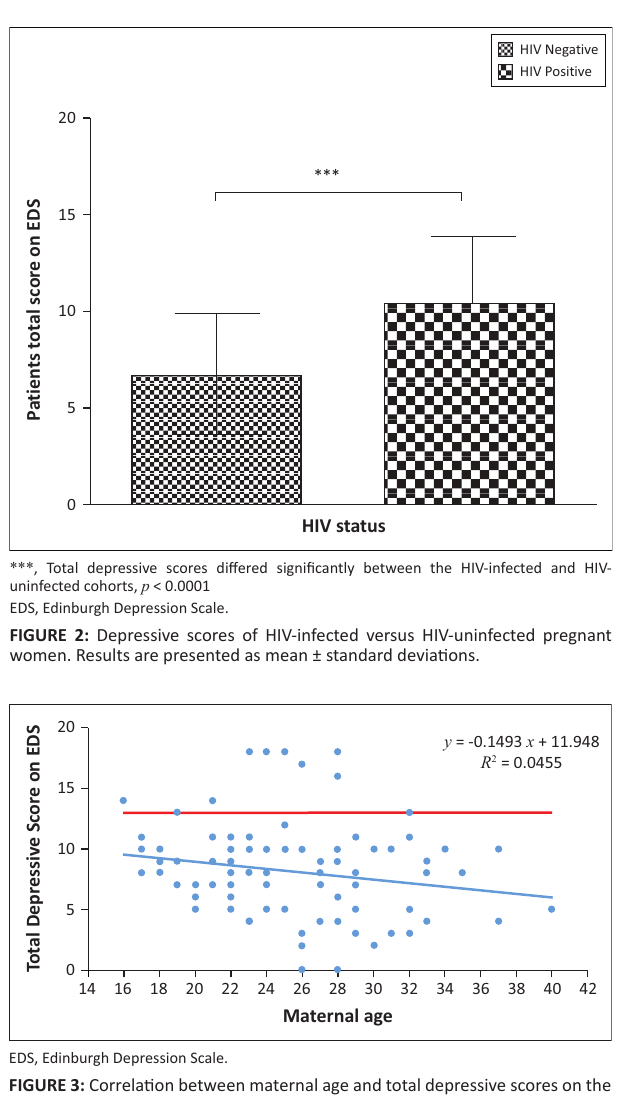
FIGURE 3: Correlation between maternal age and total depressive scores on the EDS. The red line represents the cut-off score for probable depression (13) on the EDS. * , Total depressive scores differed significantly with maternal age of women, p =